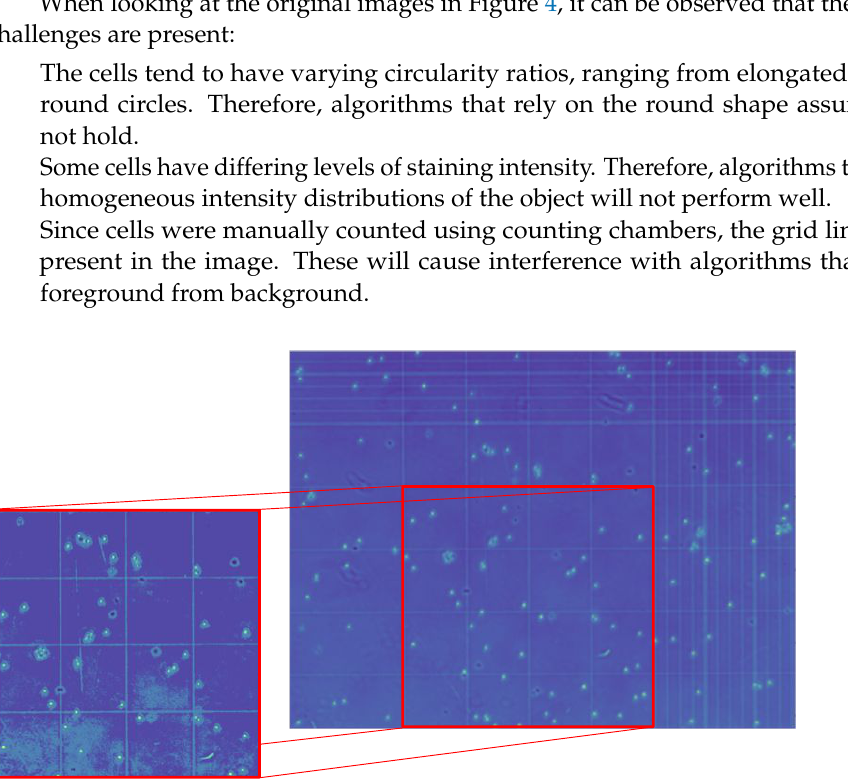
Figure 4. ( Left ) The final image after cropping. ( Right ) The original image containing many more cells than were counted on the inner grid of 16